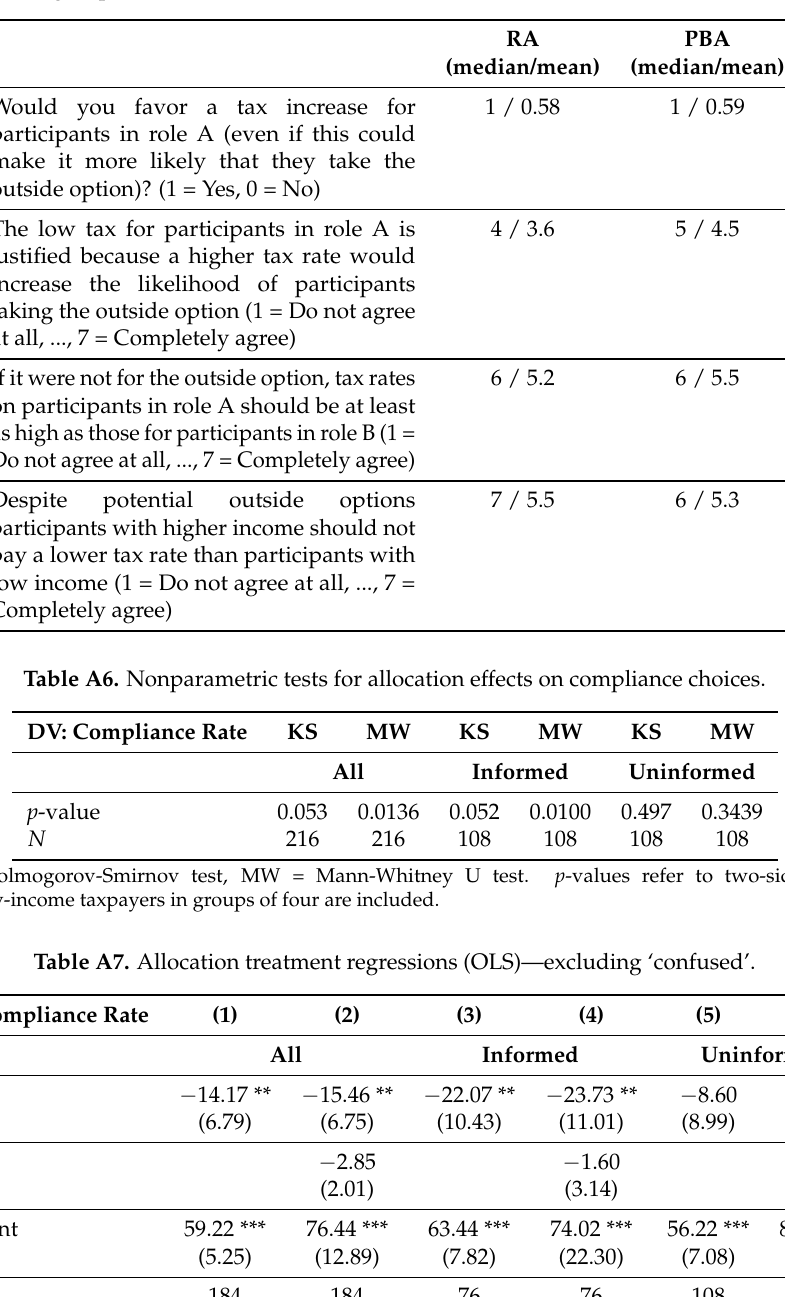
Table A5. Informed low-income taxpayers’ judgements and stated tax preferences regarding the outside option (groups of four).